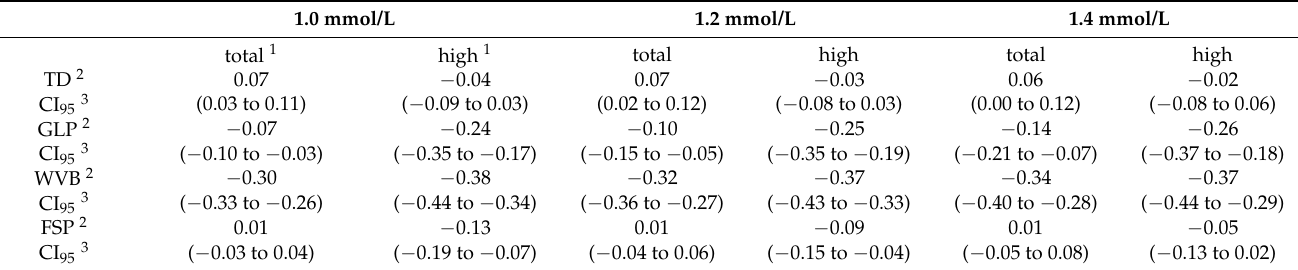
Table 5. Absolute bias from Passing–Bablok regression calculated for the classes’ total and high values for BHBA concentra- tions measured in whole blood with four handheld devices in contrast to the BHBA concentration in blood serum, analyzed in the